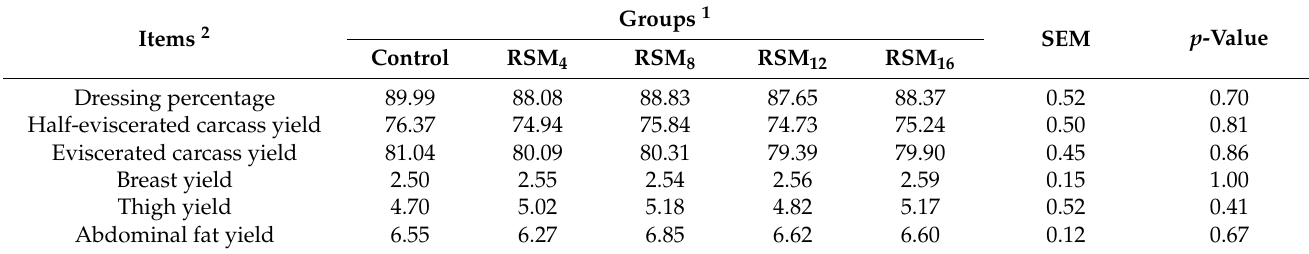
Table 4. Effects of increasing dietary levels of rapeseed meal on carcass traits of geese at 70 d of age (%).